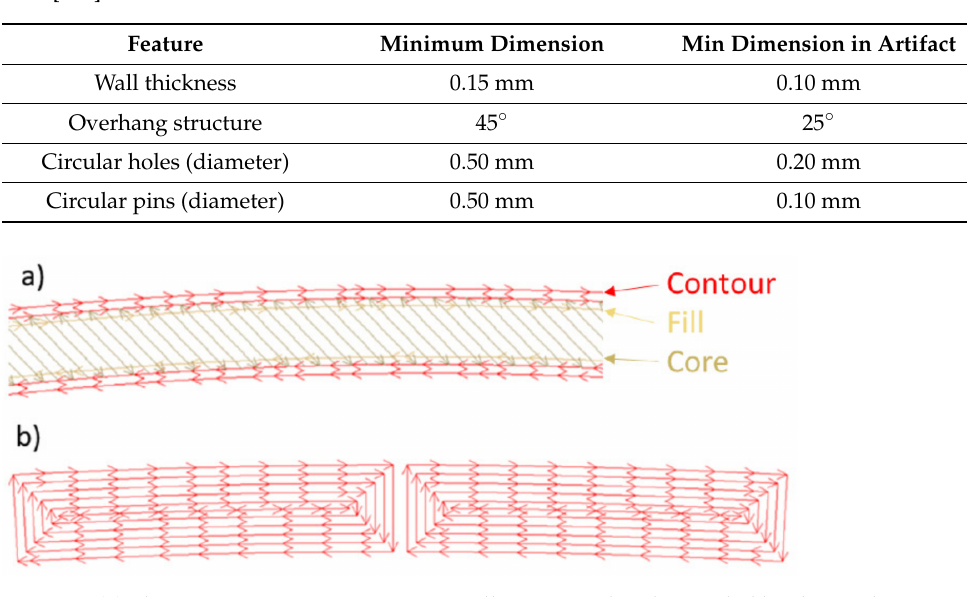
Figure 6. ( a ) The stripe scan strategy automatically generated and provided by the machine manu- facturer and ( b ) the manually designed sectional scan strategy